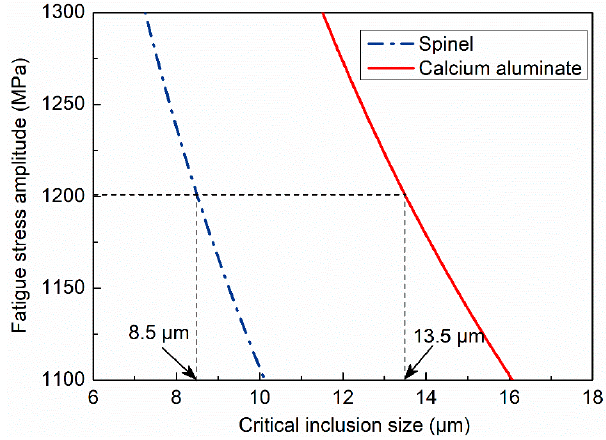
Figure 11. The critical size of spinel inclusions and calcium aluminate inclusions under di ff erent fatigue stress